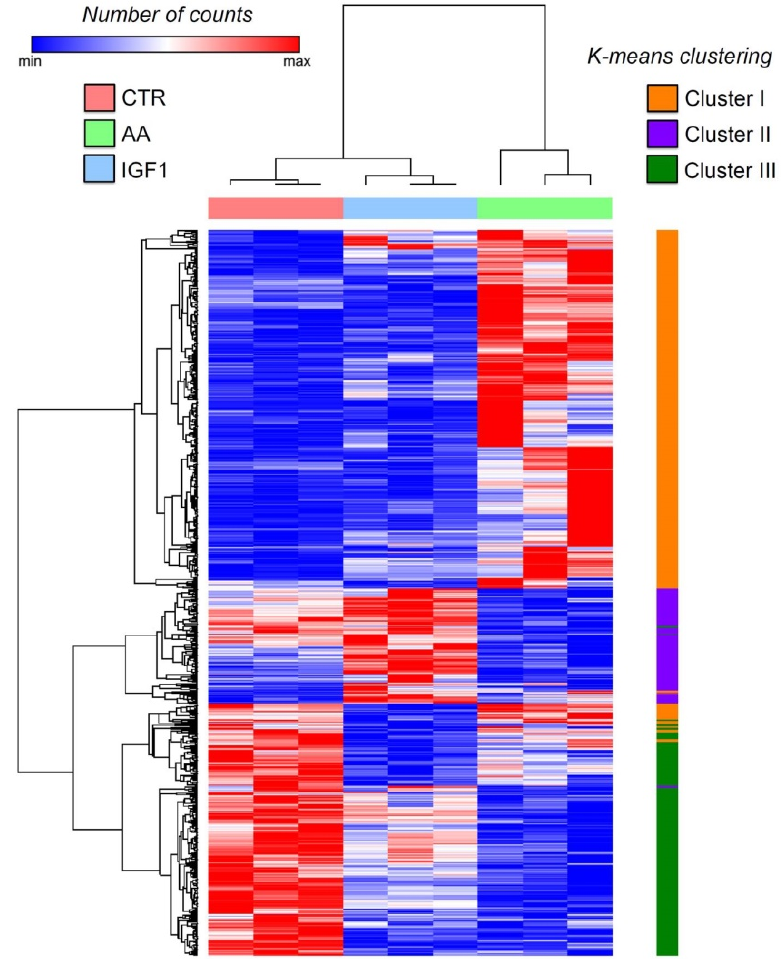
Figure 2. Transcriptome heatmap of pacu-cultured myotubes in CTR, AA, and IGF1 experimental groups. Heatmap showing gene expression according to the CTR, AA and IGF1 treatments by hierarchical clustering and non-hierarchical K-means clustering (K-means = 3). Heatmap shows the normalized read counts of differentially expressed genes, and one minus Pearson correlation was used as a metric for clustering.